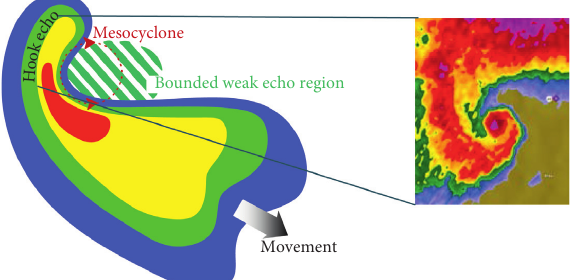
Figure 3: Conceptual model and radar reflectivity signature of hook